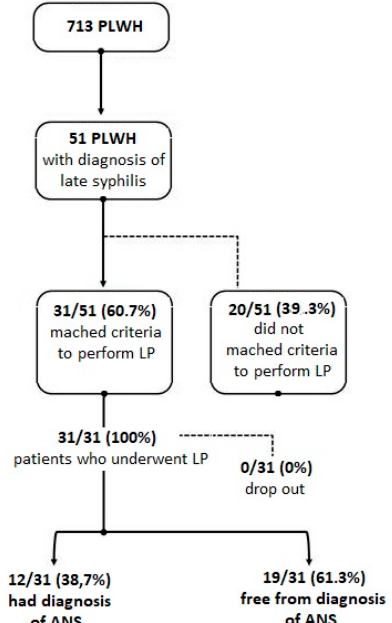
Figure 1. Standards for Reporting of Diagnostic Accuracy Studies (STARD) diagram to report flow of participants through the study.